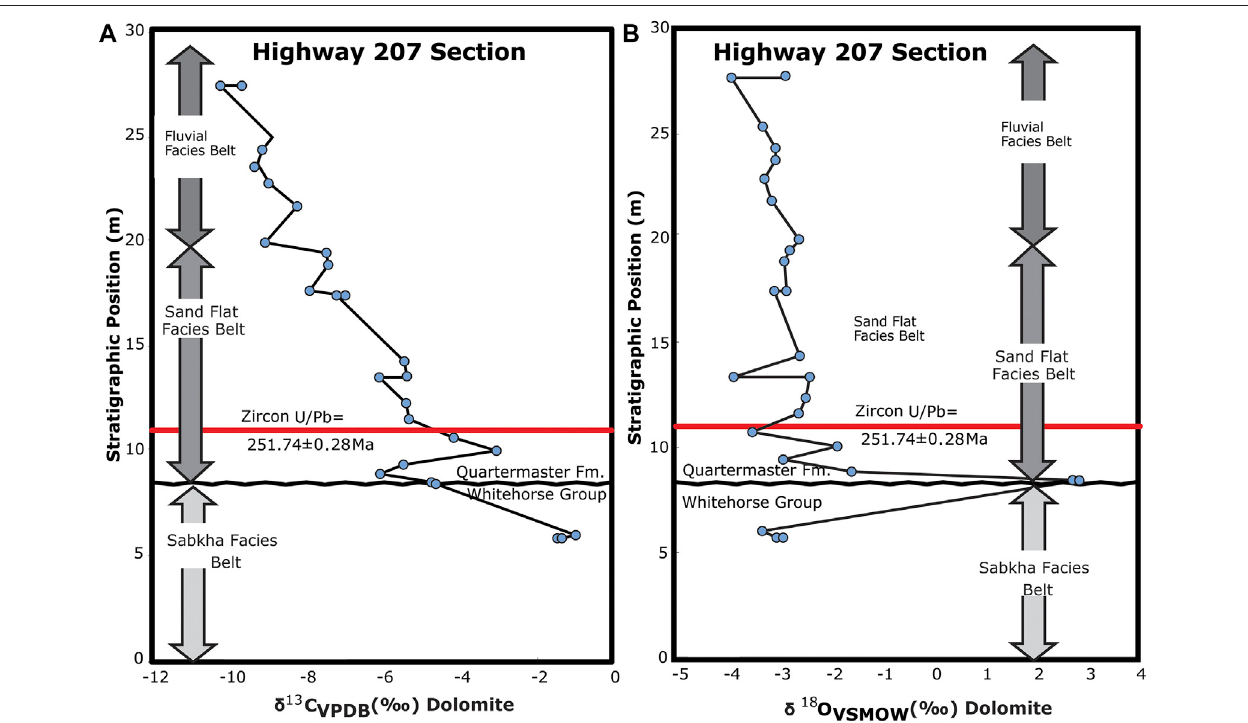
FIGURE 12 | Chemostratigraphic chart of the stratigraphic position vs. dolomite δ 13 C value of dolomicrite cements from the Highway 207 road cut stratigraphic section. (B) Chemostratigraphic chart of the stratigraphic position vs. dolomite δ 18 O value of dolomicrite cements from the Highway 207 road cut stratigraphic section. The red and black-hatcher lines in both graphs represent the position of a volcanic ash and the disconformable boundary between the lower Whitehorse Group strata and the upper Quartermaster Formation strata, respectively. See text for detailed discussion.